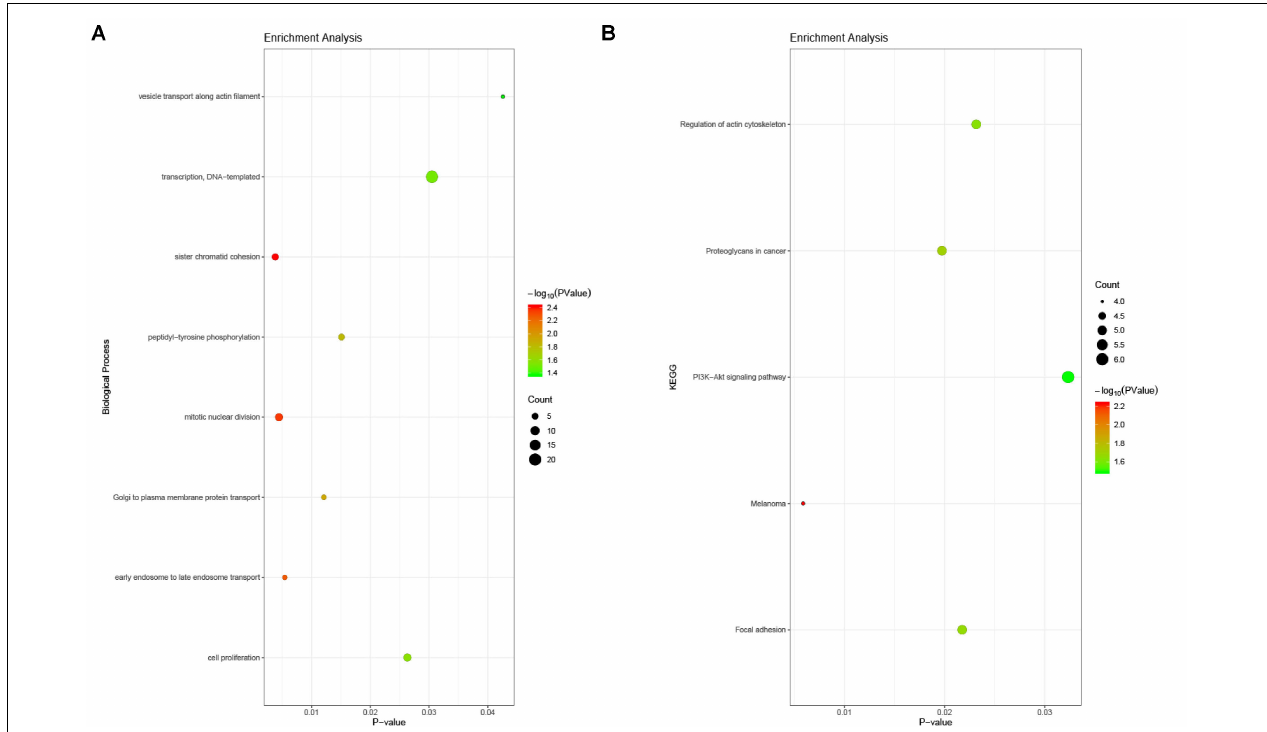
FIGURE 5 | Enrichment analysis of DEGs in PAH. (A) Biological process analysis. The biological processes consisted mainly of DNA-templated transcription, sister chromatid cohesion, mitotic nuclear division, cell proliferation, peptidyl-tyrosine phosphorylation, Golgi to plasma membrane protein transport, and so on. (B) KEGG pathway analysis. The regulation of the actin cytoskeleton, the PI3K-Akt signaling pathway, and focal adhesion were